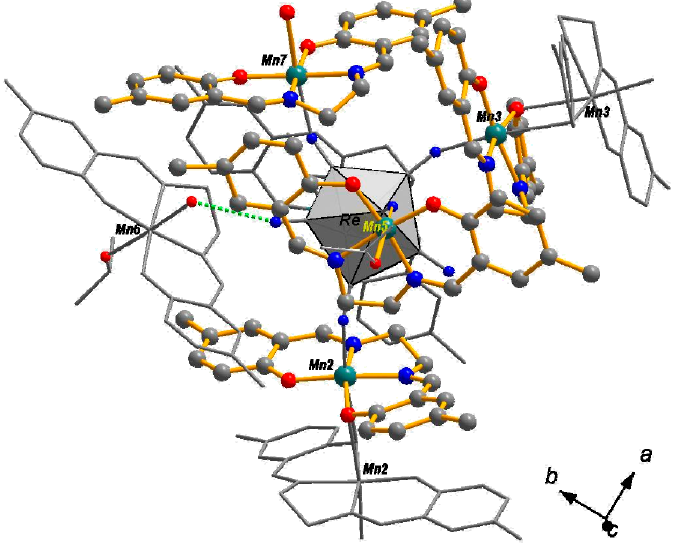
Figure 6. An asymmetric unit (ball-and-stick style) of 5 with Re polyhedron. The duplicated over the inversion center and back located {MnSB} units as well as a hydrogen bound to [Re(CN) 7 ] 3 − anion [MnSB(H 2 O) i -PrOH] + complex are painted in gray. Hydrogen atoms are omitted for clarity.